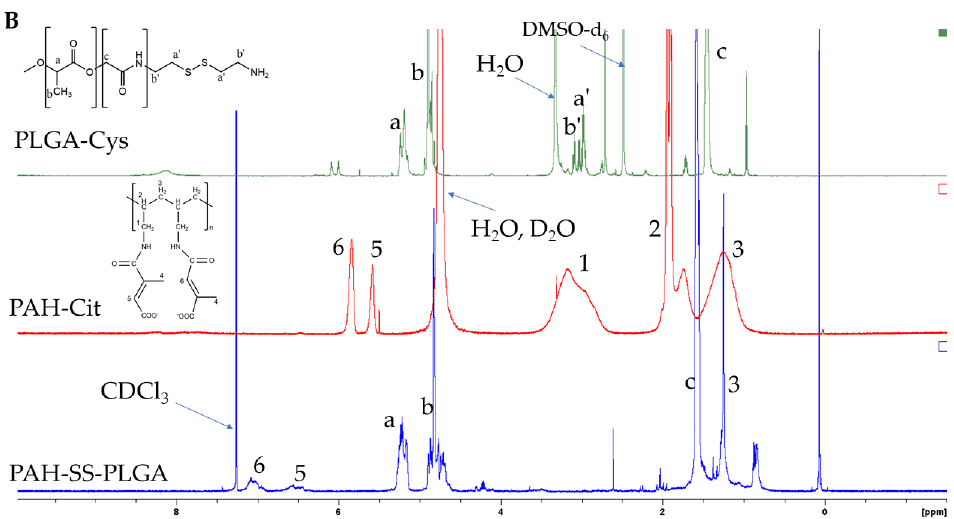
Figure 1. 1 H-NMR of ( A ) PAH and PAH-Cit and ( B ) PLGA-Cys, PAH-Cit, and PAH-SS-PLGA. Note: D 2 O was used as a solvent for PAH and PAH-Cit, whereas DMSO and CDCl3 solvent were used for PLGA-Cys and PAH-SS-PLGA, respectively. PAH: poly (allylamine hydrochloride), PAH-Cit: poly(allylamine)-citraconic anhydride, PLGA-Cys: poly(lactic-co-glycolic acid)-cystamine.